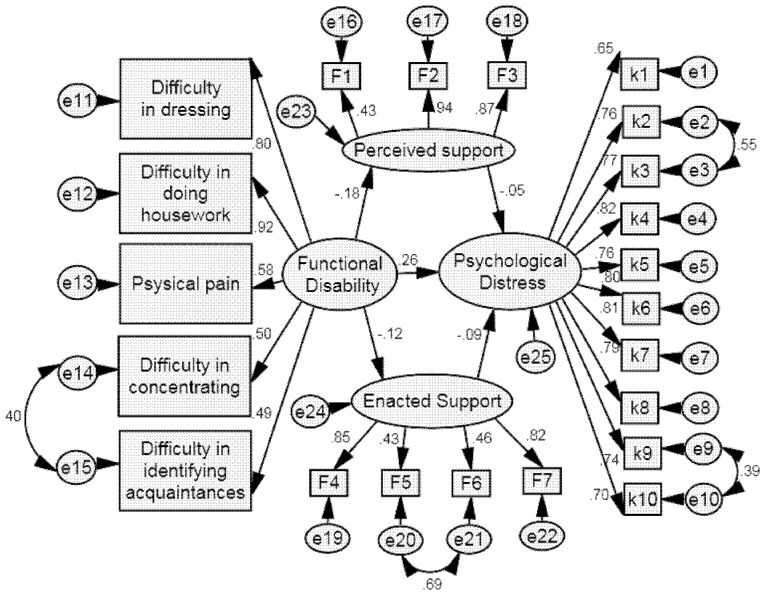
Results of SEM analysis among whole sample.All the coefficients are standardized. The path coefficient (−0.12) from functional disability to enacted support is significant at 0.01 level, that from enacted support (−0.09) to psychological distress are significant at 0.05 level, that from perceived support to psychological distress (−0.05) are not significant at 0.05 level and all other coefficients in the figure are significant at 0.001 level.